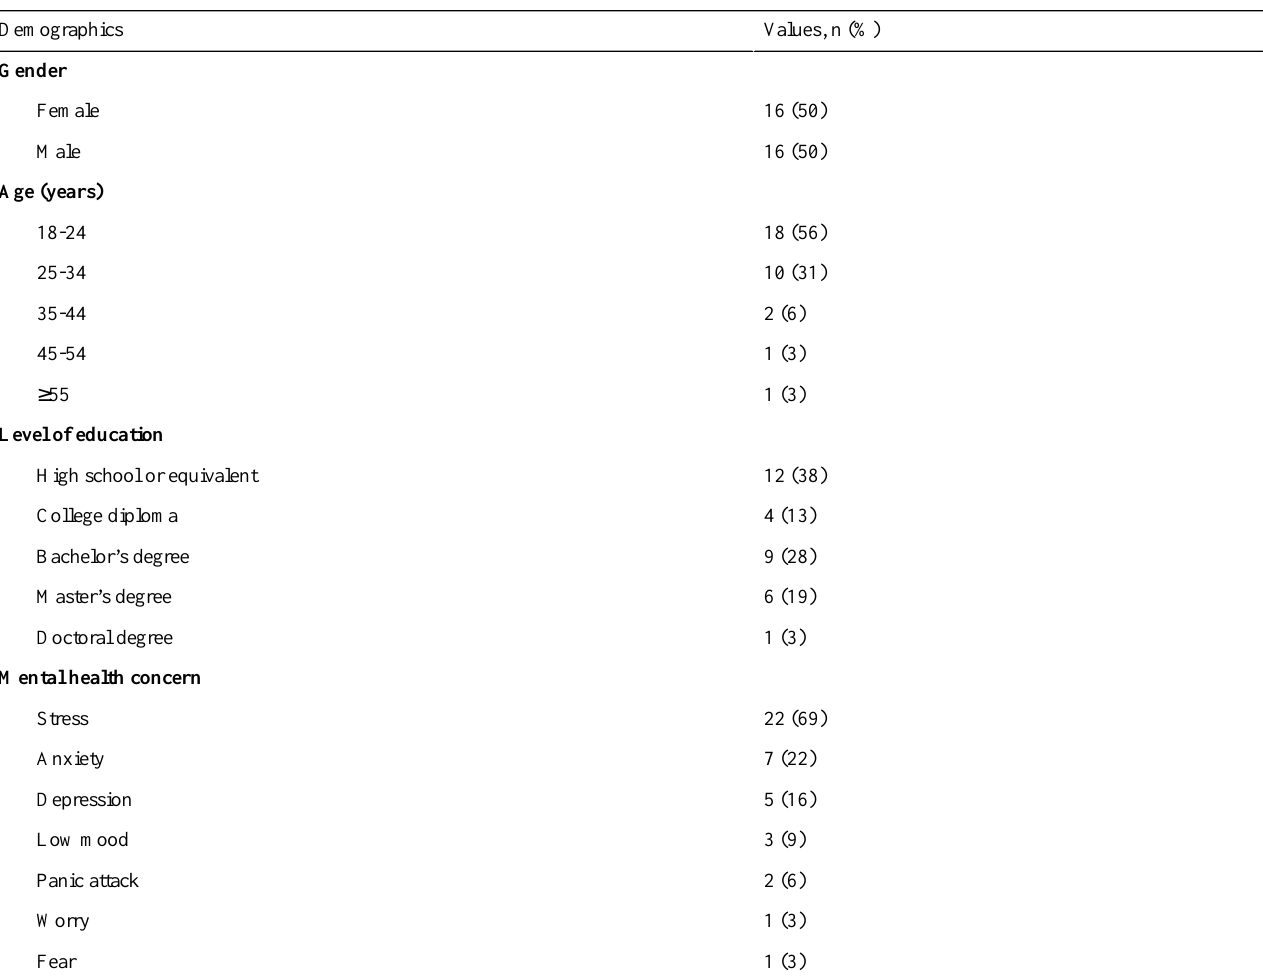
Table 1. Demographics of 32